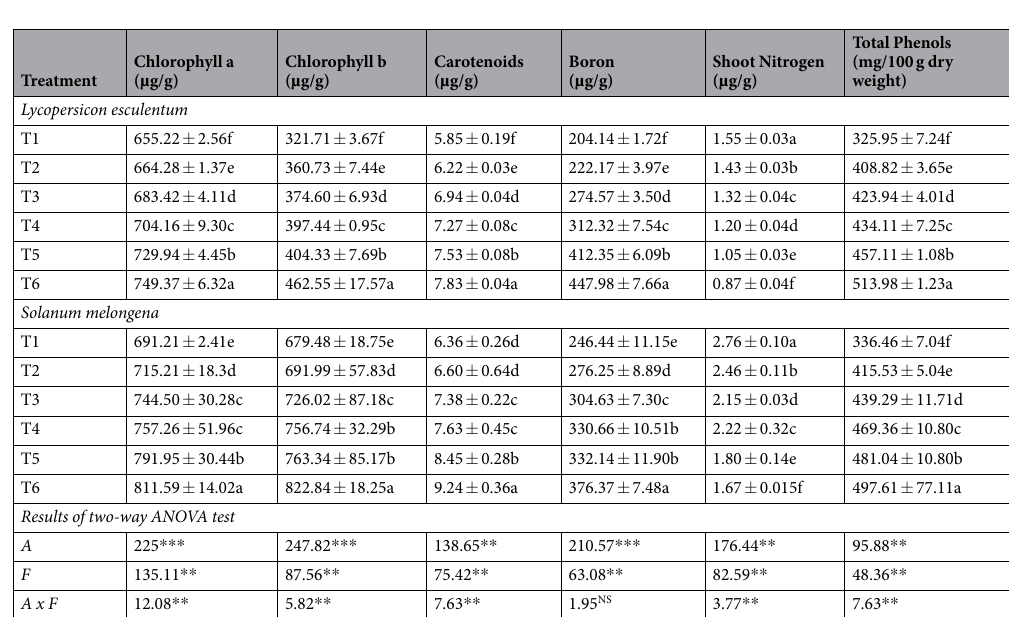
Table 6. Effects of vermicomposted fly ash amendment on photosynthetic pigments, boron, shoot nitrogen and total phenol in leaves of Lycopersicon esculentum and Solanum melongena plant during harvesting. DAS: Days after sowing. Values are in Mean ± SD, n = 3. Levels of significance: *** p < 0 . 001 ; ** p < 0 . 01 ; * p < 0 . 05 ; NS = not significant (Two-way Anova). Different letters in the same column denote significant differences ( p < 0 . 05 ) in the concentrations of chlorophyll a, chlorophyll b, carotenoids, boron, shoot nitrogen and total phenol in Lycopersicon esculentum and Solanum melongena plants respectively (One-way ANOVA; Tukey’s